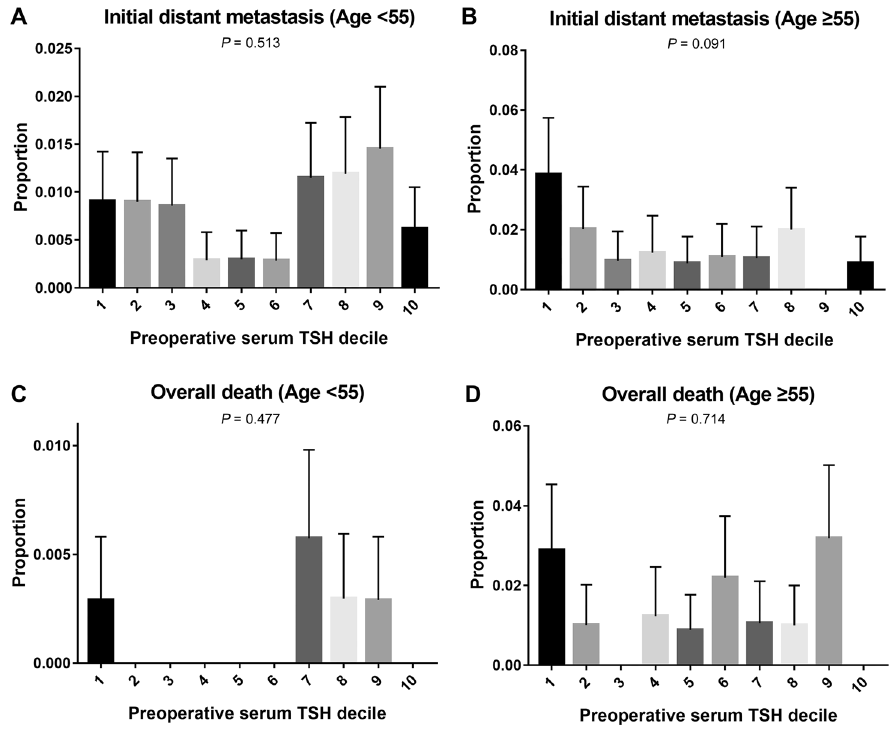
Figure 3. Subgroup analysis by age of initial distant metastasis and overall death according to preoperative TSH decile. ( A ) patients under 55 years of age with initial distant metastasis showed bimodal peaks. ( B ) however, negative correlation was seen in patients over 55 years of age. ( C,D ) overall death showed a still bimodal peak when subgroup analysis was performed according to